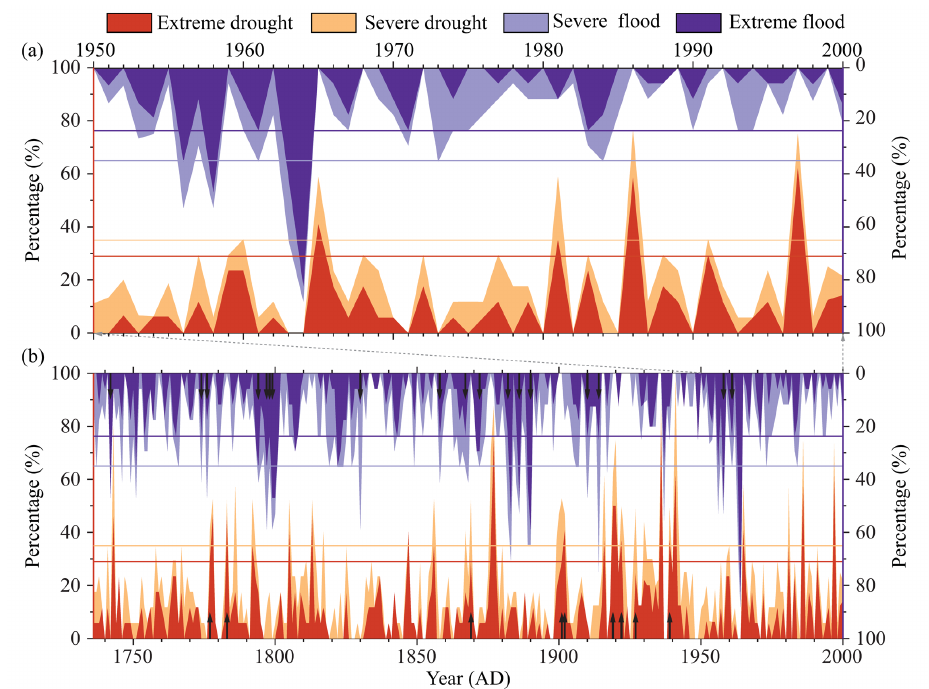
Figure 2. Percentage of sites with extreme and severe drought/flood that occurred over North China during 1736–2000. Dashed line: the criteria to identify the regional extreme drought/flood events. Symbol ↑ : the year of extreme drought/flood events which were not reported in previous studies (Chen and Yang, 2013; Hao et al., 2010a, b; Shen et al., 2007, 2008; Zhang, 2005; Zheng et al.,